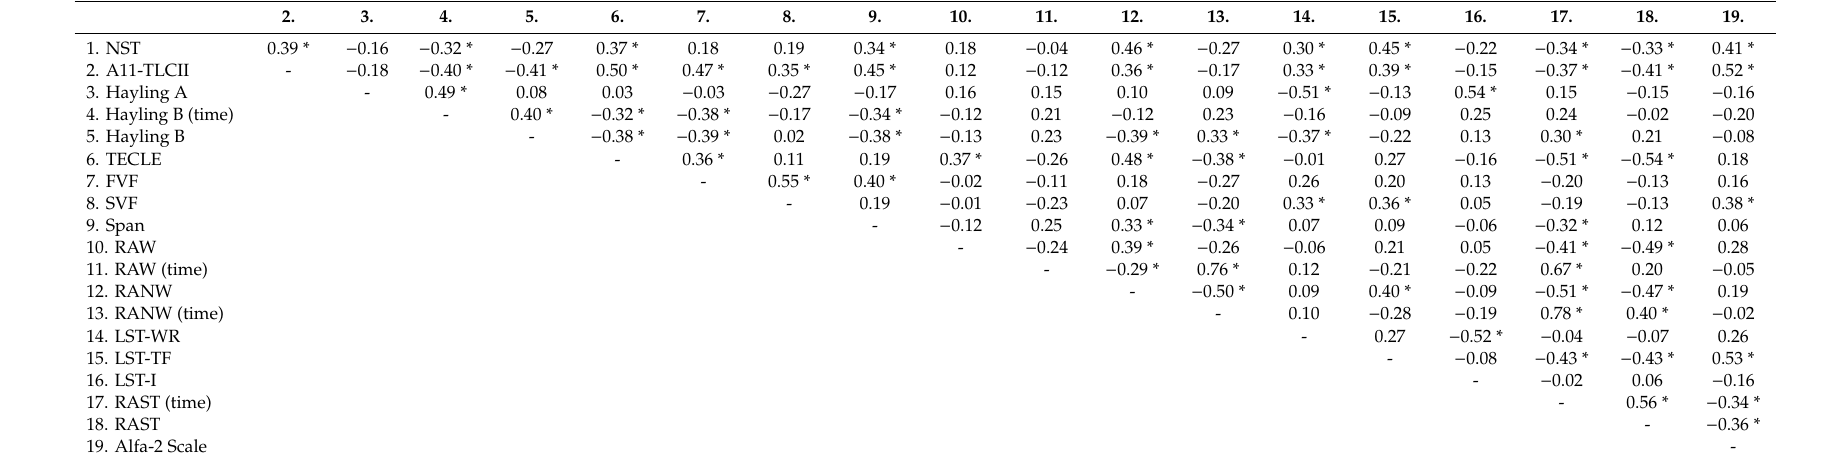
Table 2. Pairwise correlations (rho) across all